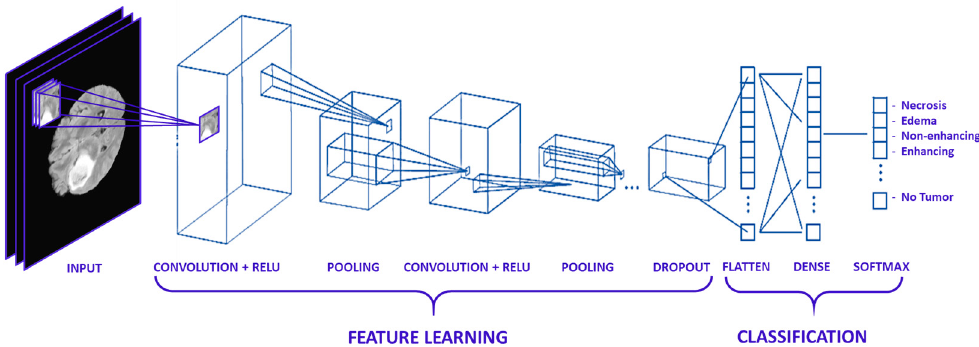
Figure 8. Typical CNN Architecture MR Image Classification.